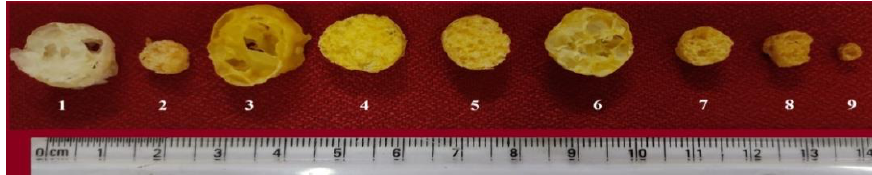
Figure 2. Cross section view of extrudates prepared with rice flour, corn flour, coconut milk residue and neera honey ( 1 ) 100% RF + 16% FM (water), ( 2 ) 100% RF + 16% FM (NH), ( 3 ) 100% CF + 16% FM (water), ( 4 ) 100% CF +16% FM (NH), ( 5 ) 50% RF + 50% CF + 16% FM (NH), ( 6 ) 50% RF + 50% CF + 16% FM (water), ( 7 ) 60% RF + 25% CF + 15% CMR + 16% FM (NH), ( 8 ) 100% RF + 20% FM (NH), ( 9 ) 85% RF + 15% CMR + 20% FM (NH). Table 5. Physical properties of neera honey incorporated extrudates.